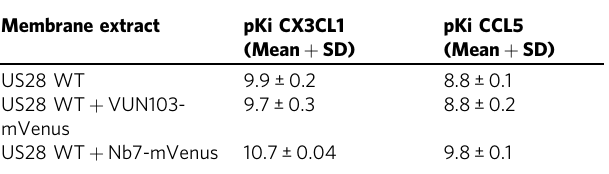
Table 1 pKi values of CX3CL1 and CCL5 to different membrane